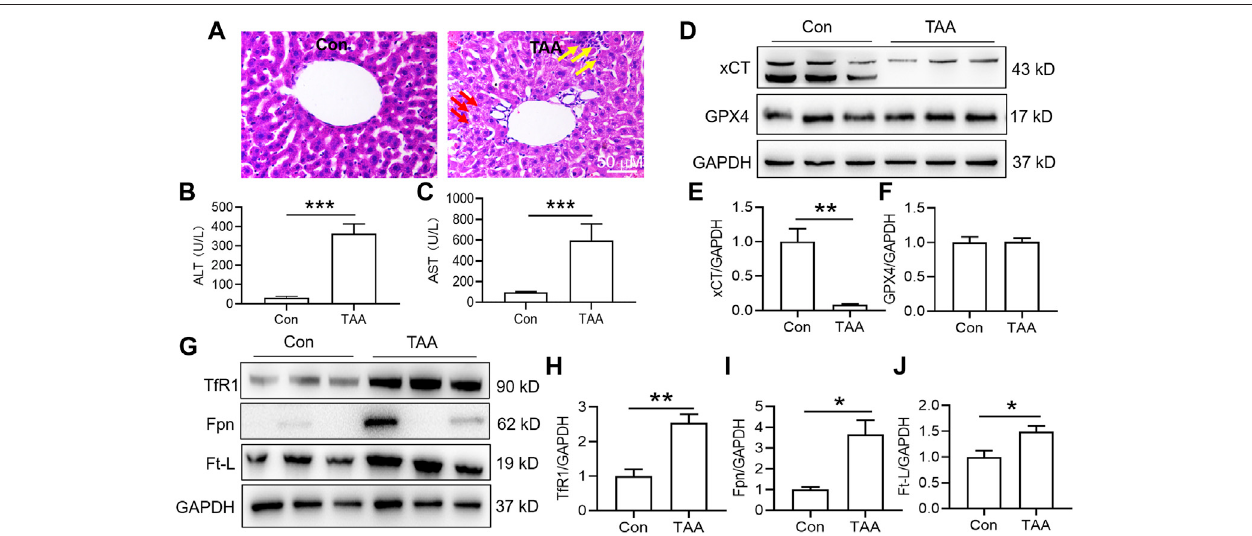
FIGURE 1 | TAA induced liver dysfunction, suppressed anti-ferroptosis-related protein expression and enhanced iron-related protein expression in the liver. (A) Liver injury was assessed by H&E staining and histological examination in mice with or without TAA administration for 3 days (bar = 50 μ m). TAA induced prominent in fl ammation(yellowarrow)andvacuolardegeneration(redarrow)intheliverwithin3 dayscomparedwiththecontrolgroup. (B) PlasmaALTand (C) ASTlevelsincontrol and TAA-injected mice. (D) Western blotting analysis of xCT and GPX4 expression in the livers of mice with or without TAA treatment. (E – F) Relative protein expression levels of xCT and GPX4. (G) Western blotting analysis of TfR1, Fpn and Ft-L expression in the livers of mice with or without TAA treatment. (H – J) Relative protein expression levels of TfR1, Fpn and Ft-L. All data are presented as the mean ± SEM (n = 6-9 mice per group); * p < 0.05, ** p < 0.01 and *** p < 0.001 versus the indicated